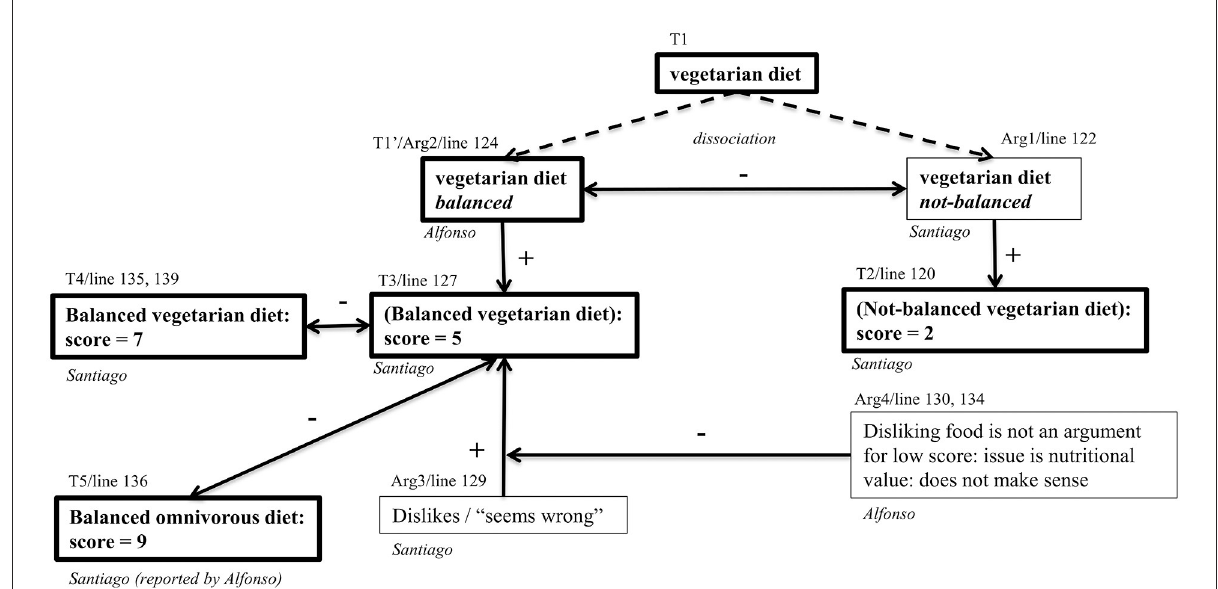
FIGURE5 Argument diagram of the episode on scoring vegetarian diet. Boxes with thick lines are claims, that become theses (T1, T2) once argued; boxes with simple lines are (counter-) arguments; “ + ” and “–” are arguments for or against; dotted arrows represent elaborations of theses (rather than arguments), noted T ′ . The bi-directional arrow expresses that the boxes it links are mutually contradictory, each being an argument against the